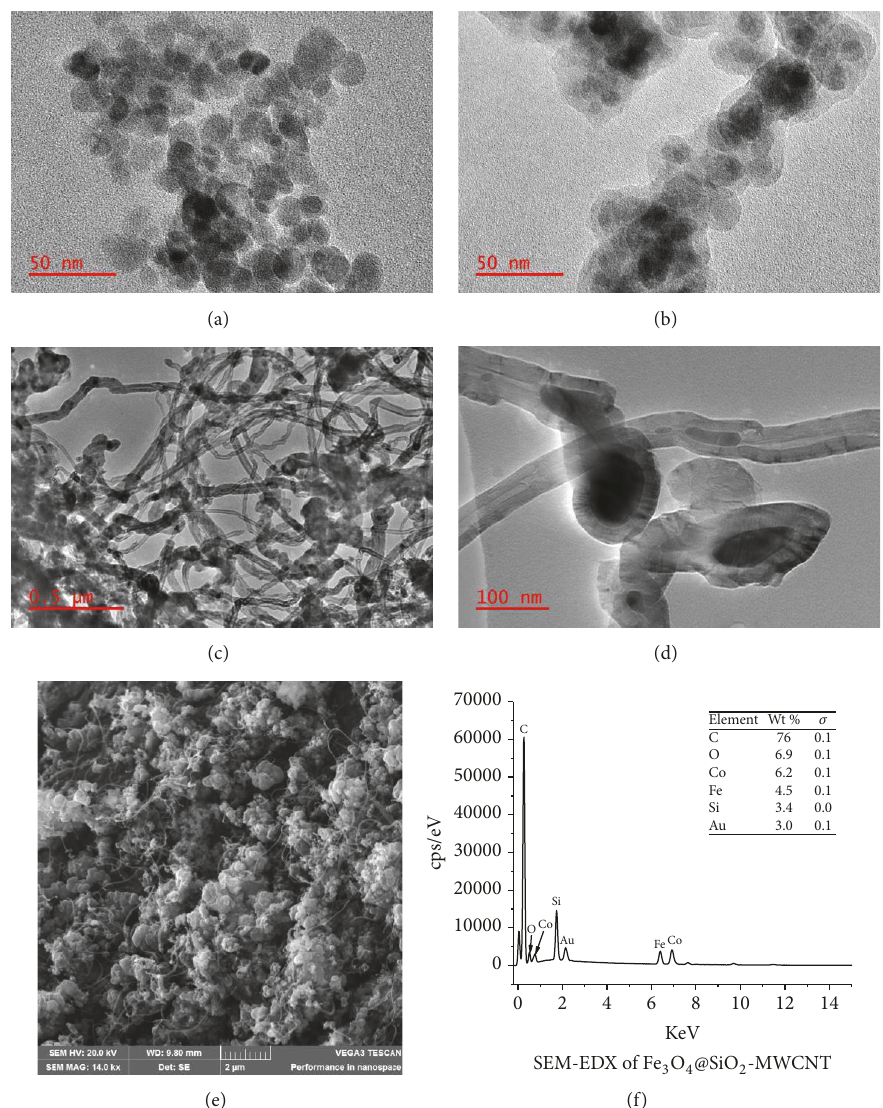
Figure 1: TEM image of Fe 3 O 4 (a), Fe 3 O 4 @SiO 2 (b), Fe 3 O 4 @SiO 2 -MWCNT (c-d), SEM image of Fe 3 O 4 @SiO 2 -MWCNT (e), and SEM-EDX of Fe 3 O 4 @SiO 2 -MWCNT